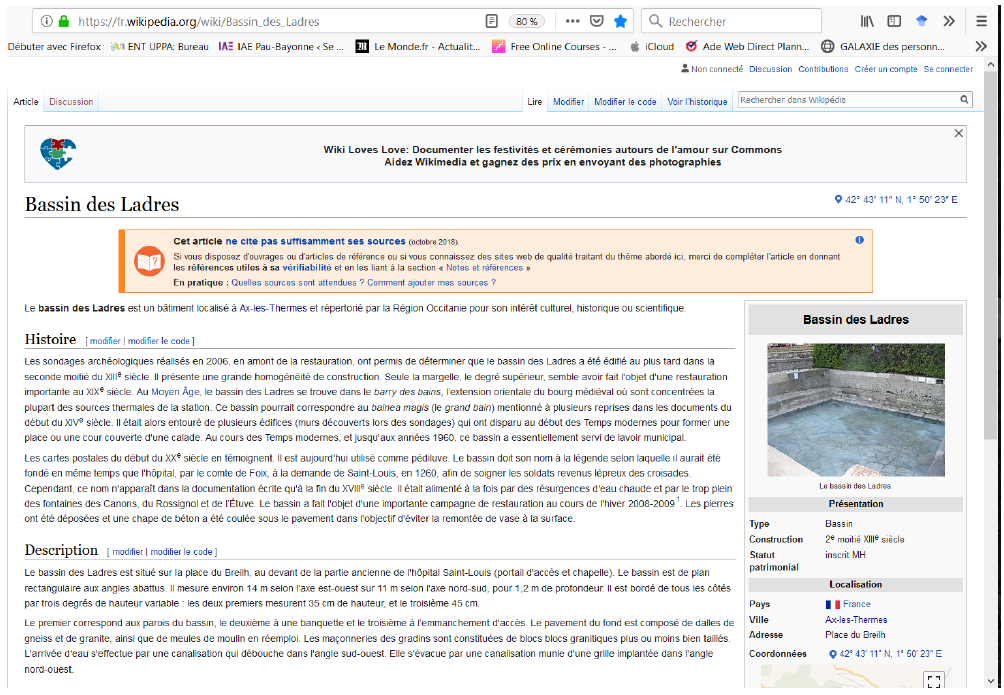
Figure 6. An example of a cultural heritage object (POI) exported to